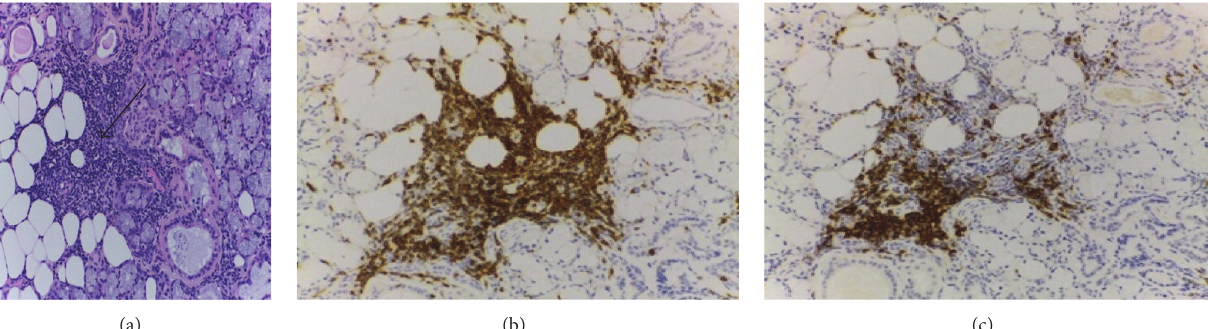
Figure 3: Submaxillary gland biopsy. (a) H&E 10 × 20 —one focus of lymphocytic infiltrate (black arrow). (b) Immunohistochemistry—T lymphocytes (CD3+). (c) Immunohistochemistry—B lymphocytes (CD20+).